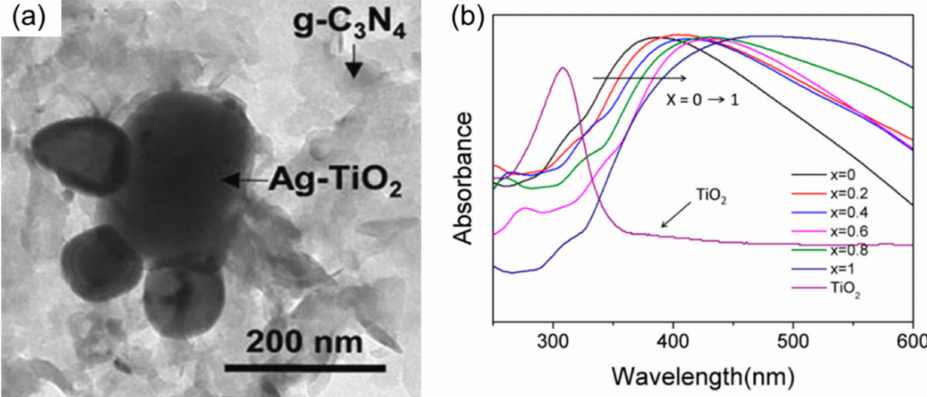
Figure 3. ( a ) TEM images of Ag/TiO 2 /g-C 3 N 4 (Reprinted from [75] with permission of Elsevier, 2022) and ( b ) UV–vis spectra of Au x Ag (1 − x) /TiO 2 composites (x = 0, 0.2, 0.4, 0.6, 0.8, and 1) and the pure TiO 2 spheres (Reprinted from [80] with permission of MDPI,